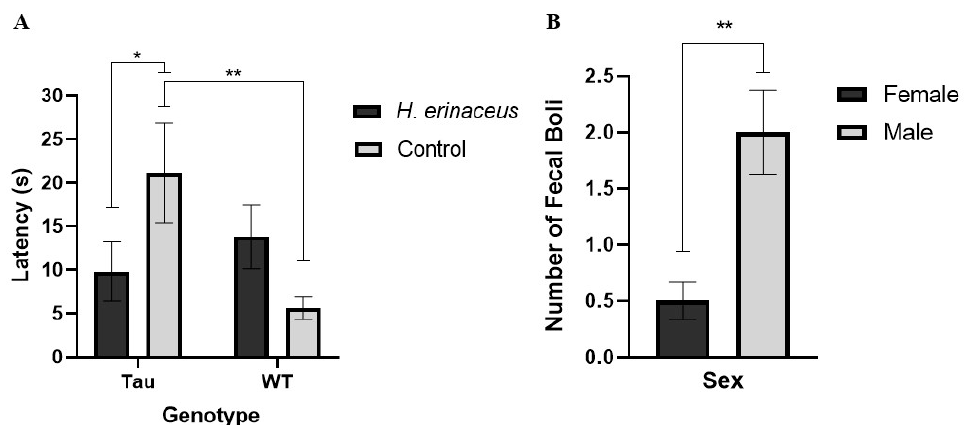
Figure 4. Open field test measures. ( A ) Tau control mice had significantly longer latencies to enter the center compared to WT control mice. Tau mice supplemented with H. erinaceus had significantly shorter latencies in entering the center of the OF compared to tau control mice. ( B ) Male mice defecated more than females. Error bars represent mean ± SEM (* p < 0.05, ** p <